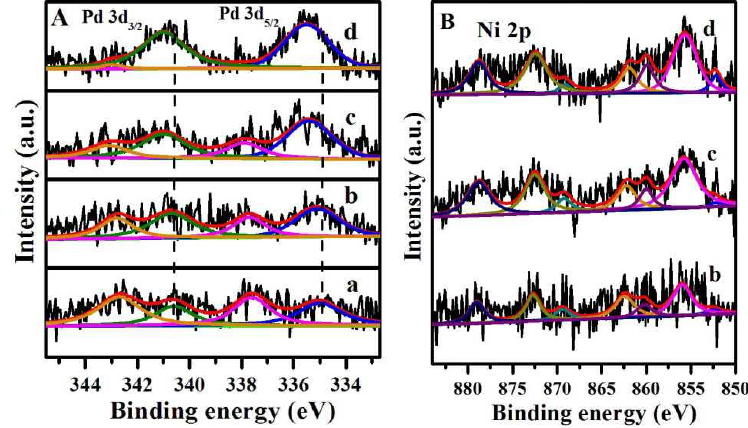
Figure 5. XPS spectra of ( A ) Pd3d and ( B ) Ni2p of the catalysts (a) 0.2%/SBA-15, (b) 0.2%Pd-0.4%Ni/SBA-15, (c) 0.2%Pd-0.7%Ni/SBA-15, (d) 0.2%Pd-1.2%Ni Table 2. XPS data of the Pd3d levels for different samples.